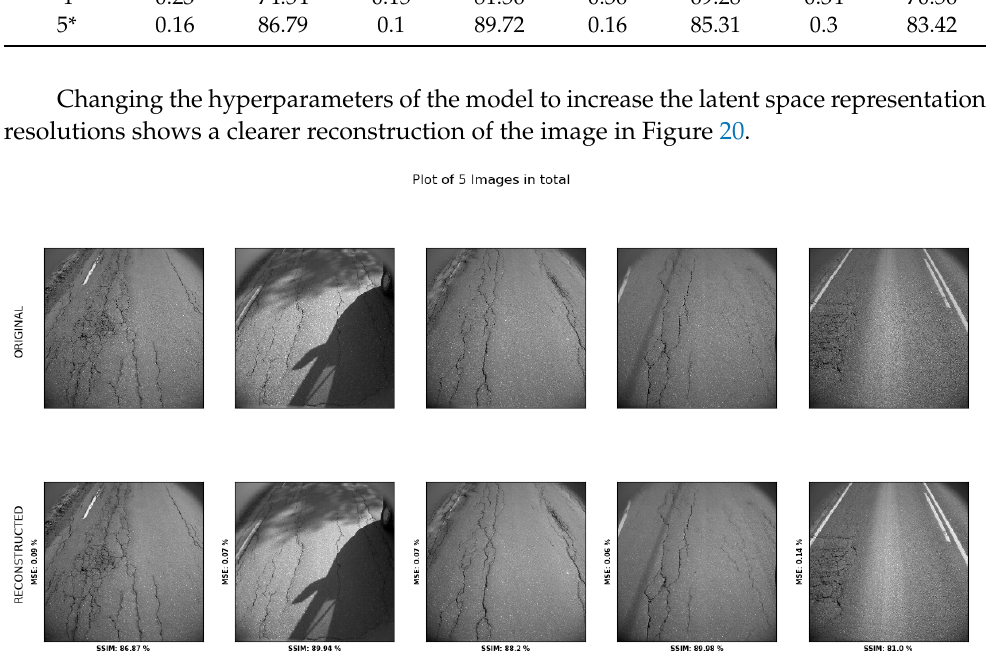
Figure 20. Model performance with adjusted hyperparameters visualized, with the bottom road showing the reconstructed images and the top row showing the original image. These are for tests of no-, low-, and medium-damage classes.